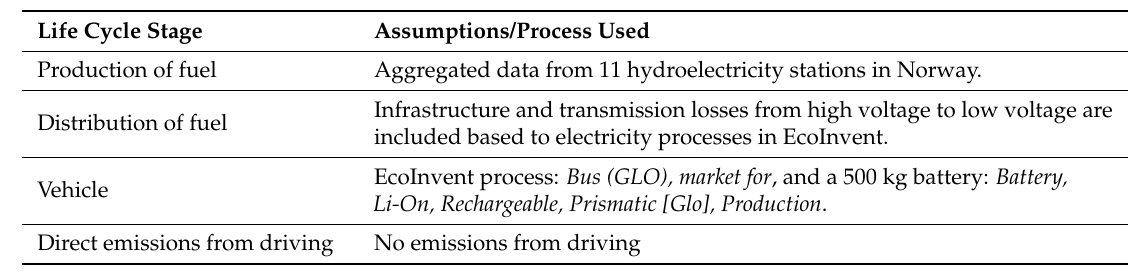
Table A4. Electricity hydropower.